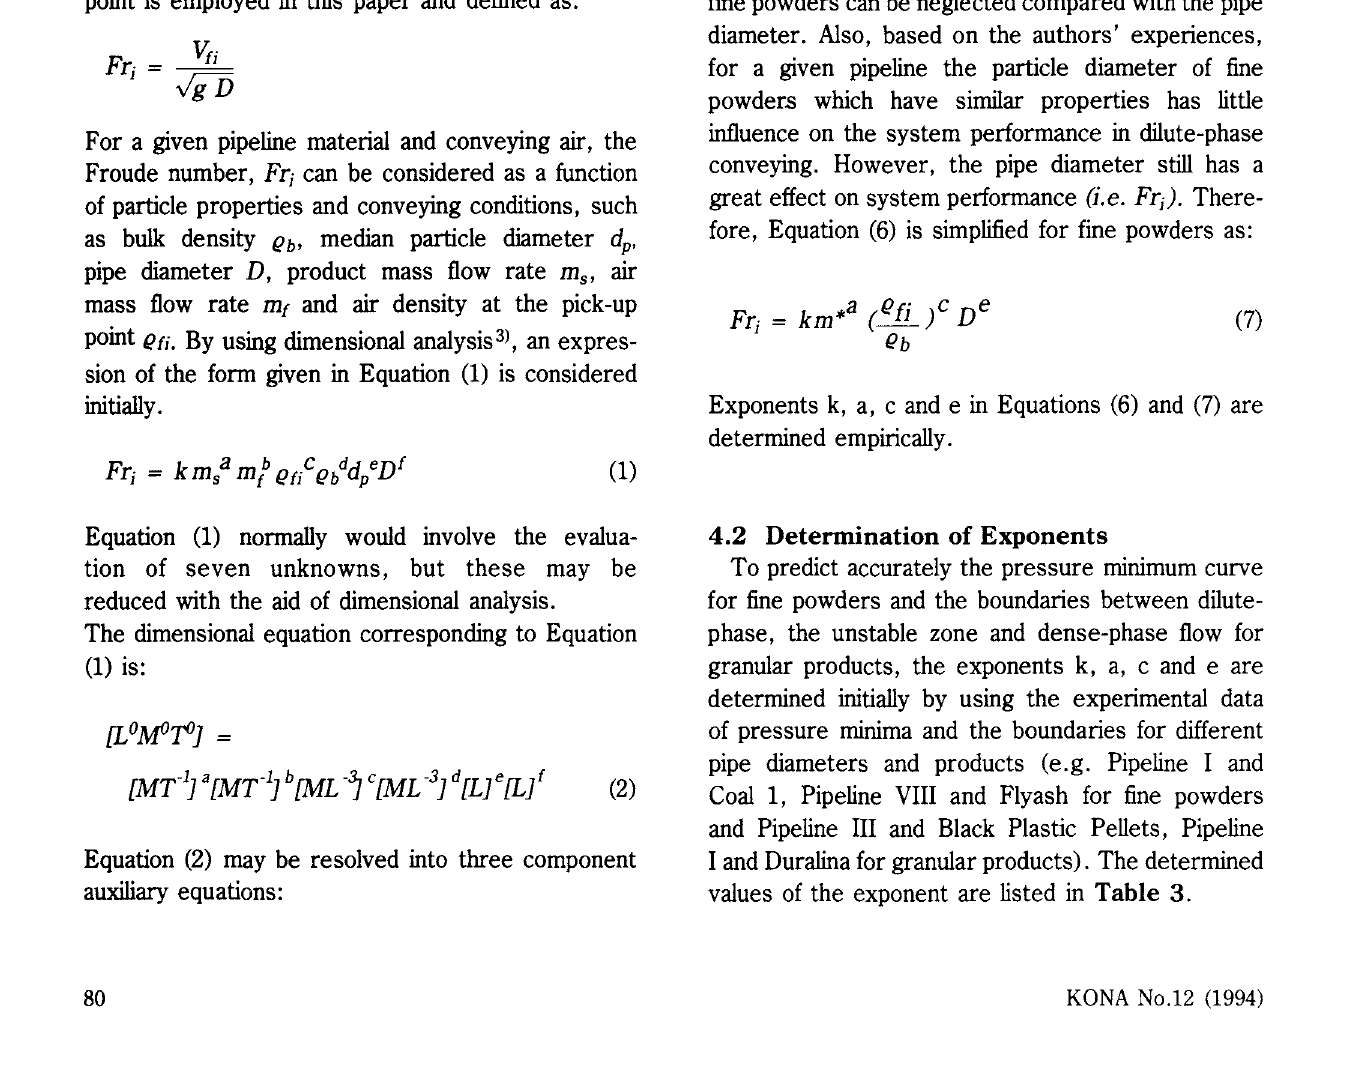
Fig. 10 Steady-state conveying characteristics of Wheat and Pipeline